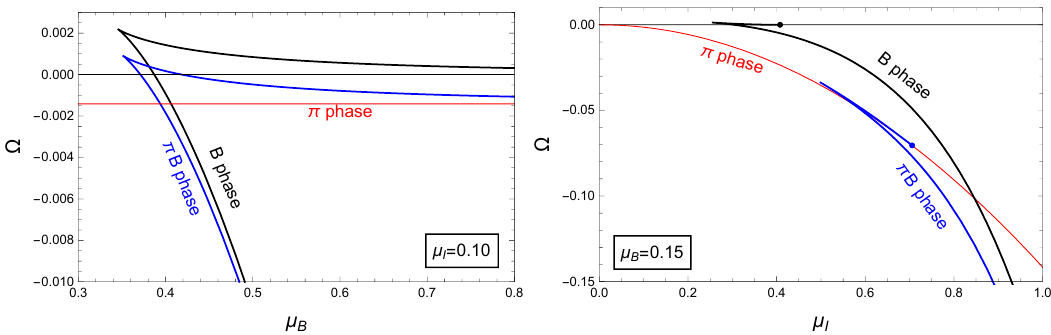
Figure 4: Dimensionless free energy density for the different phases as a function of µ = 0.10 (left panel) and as a function of µ fixed µ I λ = 15. The unlabeled thin (black) horizontal line is the vacuum Ω = 0. In both cases, the ground state evolves from the pion-condensed phase via a first-order phase transition to the π B phase, where pions and baryons